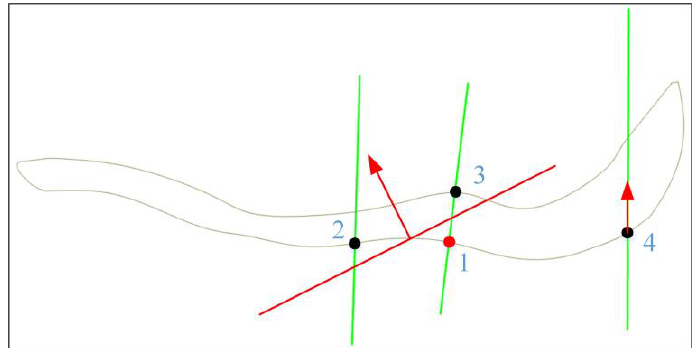
Figure 13. Point-Cloud Normal Vector Calculation.